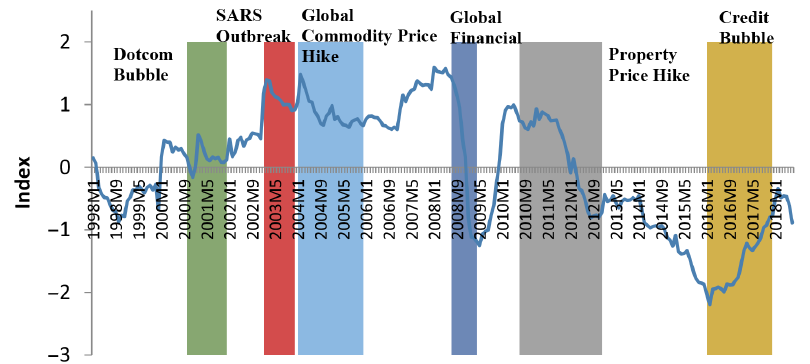
Figure 1. Financial vulnerability indicator for China. Shaded areas indicate vulnerability based on reports of various issues on China by the